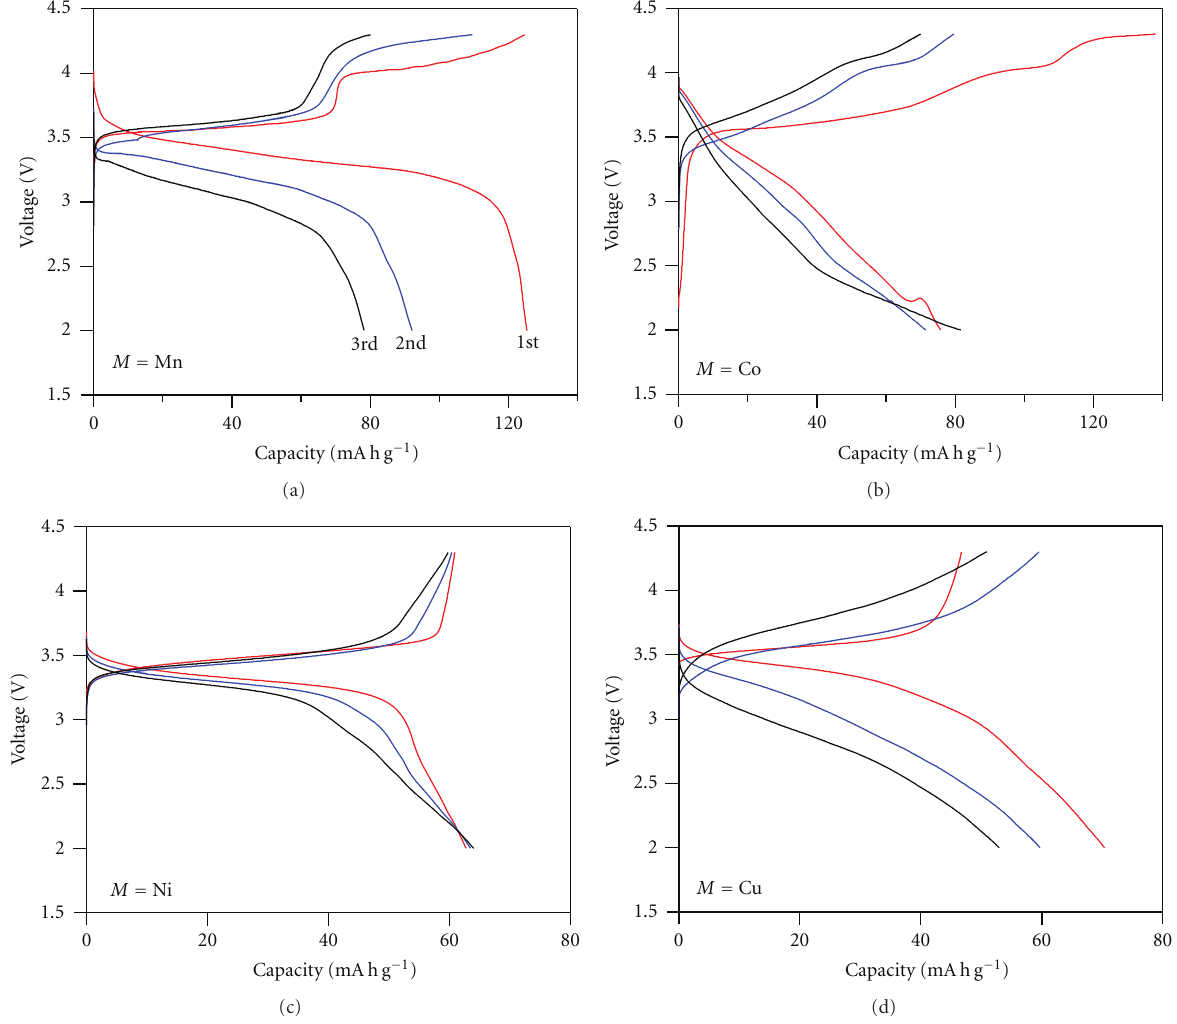
Figure 1: Charge/discharge curves of the paste-type electrode of Na x M [Fe(CN) metal at the 1st (red), 2nd (blue), and 3rd (black)